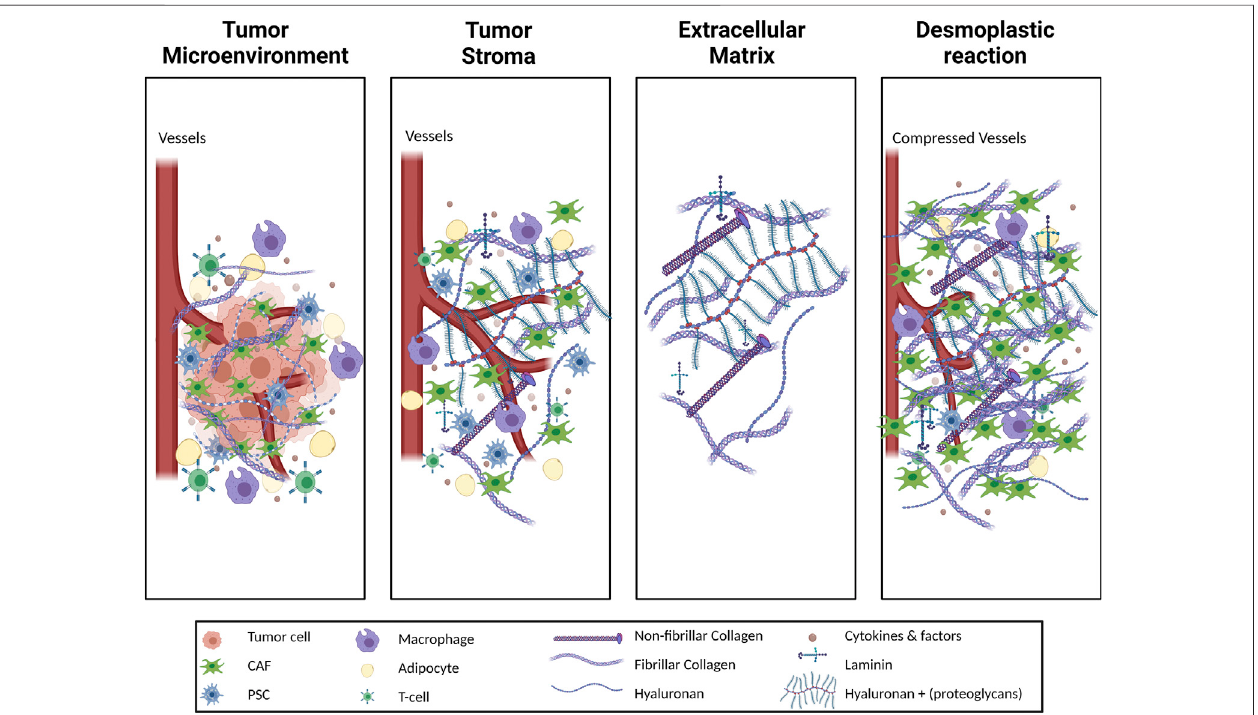
FIGURE1| Schematicillustrationofdifferenttermsusedtodescribethetumorstroma.Thetumormicroenvironment(TME)ofpancreatic adenocarcinoma(PDAC) includes the tumor cells in addition to the stroma. The stroma is a complex milieu of non-tumor cells, cytokines, growth factors and the proteins of extracellular matrix (ECM).TheECMconsistsofthenon-cellularstructuralarrangementofthetissueandishighlyproteinaceous.CellularcomponentsofPDACstromaincludeimmunecells such as T-cells and macrophages, as well as stromal cells such as adipocytes and pancreatic stellate cells (PSCs) which are a source of cancer associated fi broblasts (CAFs). CAFs and, to a lesser extent, tumor cells alter the ECM composition by means of increased collagen, both fi brillar and non- fi brillar, deposition as well as laminins, hyaluronan and other proteoglycans. The pathophysiological increase of ECM protein content in the TME results in a desmoplastic reaction, generating denser,stiffertissuethaninthehealthypancreaticsetting.Consequencesofthedesmoplasticreactionareaconstrainedbloodvessels,in fi ltrationaroundthetissue,and a corresponding reduction of fl uid perfusion into the tissue, which in turn cultivates a hypoxic TME.